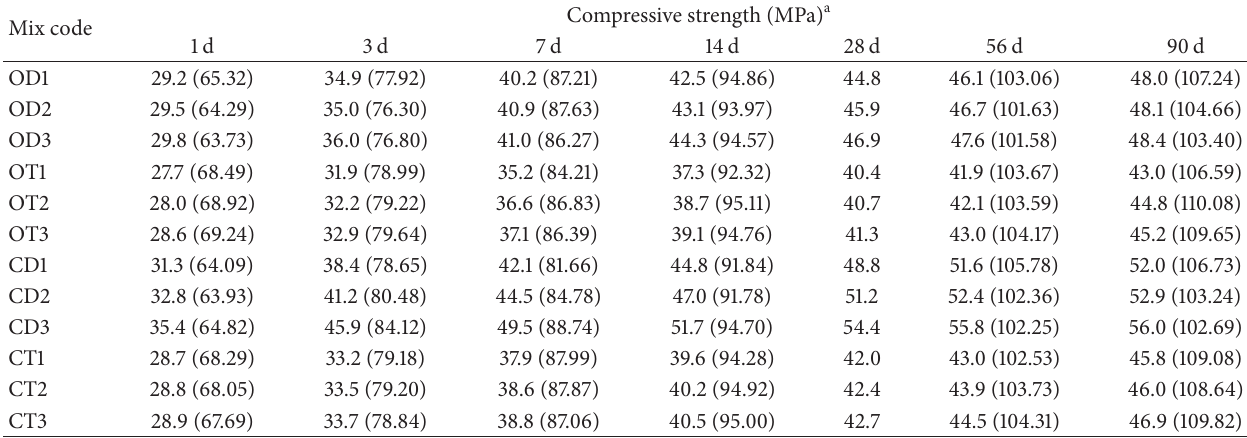
Table 5: Development of compressive strength of lightweight OPSC under continuous moist